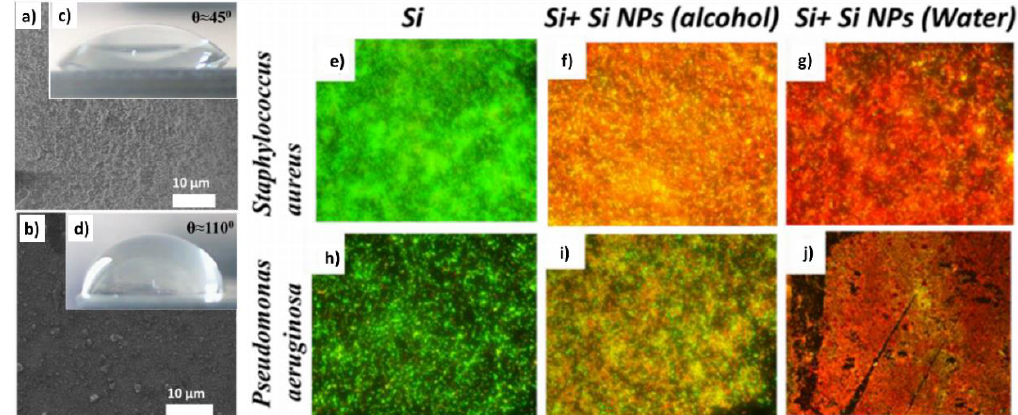
Figure 5. Top-view SEM images of coatings made of silicon nanoparticles (NPs) prepared in ( a ) water and ( b ) alcohol. Contact angles of wetting for the coatings prepared in ( c ) water and ( d ) alcohol. Optical images of assays of live (green) and dead (red) cells from bacteria biofilms on: bare silicon wafer ( e , h ), on silicon NP (prepared in isopropyl alcohol) coating on the silicon wafer ( f , i ) and on silicon NP (prepared in water) coating on the silicon wafer ( g , j ) (Reproduced with permission from [108]. IOP Publishing, 2018).